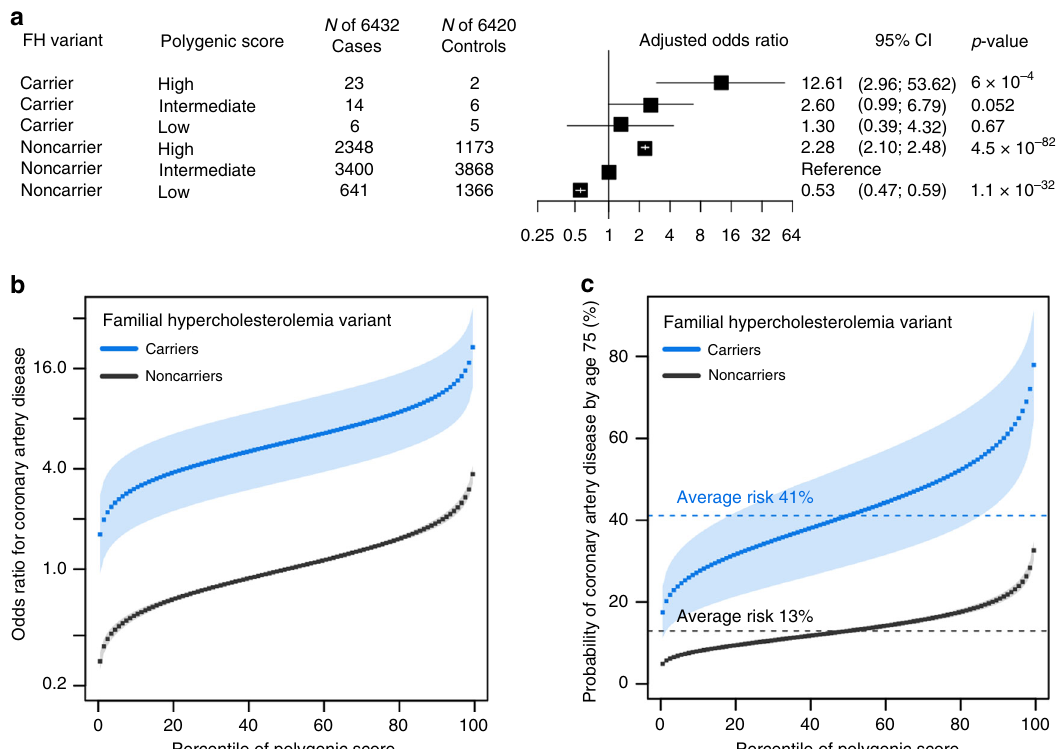
Fig. 1 Interplay of monogenic and polygenic risk for coronary artery disease. a Risk of coronary artery disease by monogenic and polygenic risk strata (case-control study; n = 12,852). Carriers and noncarriers were strati fi ed into three groups according to their polygenic score — low, intermediate, or high de fi ned as the lowest quintile, the middle three quintiles, and the highest quintile of the polygenic score distribution, respectively. The odds ratio was assessed in a logistic regression model with age, sex, and the fi rst four principal components of ancestry as covariates. Noncarriers with intermediate polygenic score served as the reference group. The black boxes indicate the adjusted odds ratio. The horizontal lines around the black boxes indicate the 95% con fi dence intervals. b Predicted odds ratio for coronary artery disease in each percentile (dots) of the polygenic score distribution for carriers (blue) and noncarriers (black) of familial hypercholesterolemia variants in the cohort study derived from the UK Biobank ( n = 48,812). Noncarriers with median polygenic score served as the reference group. c Predicted probability of coronary artery disease by age 75 years in each percentile (dots) of the polygenic score distribution for carriers (blue) and noncarriers (black) of familial hypercholesterolemia variants in the cohort study derived from the UK Biobank ( n = 48,812). The shaded area around the dots represents the 95% con fi dence interval. The horizontal dashed lines show the probability of disease for people with average polygenic risk score. FH familial hypercholesterolemia. p -values in the fi gure were estimated by the Wald Test. Statistical signi fi cance was set at p < .05, and two-sided p values were